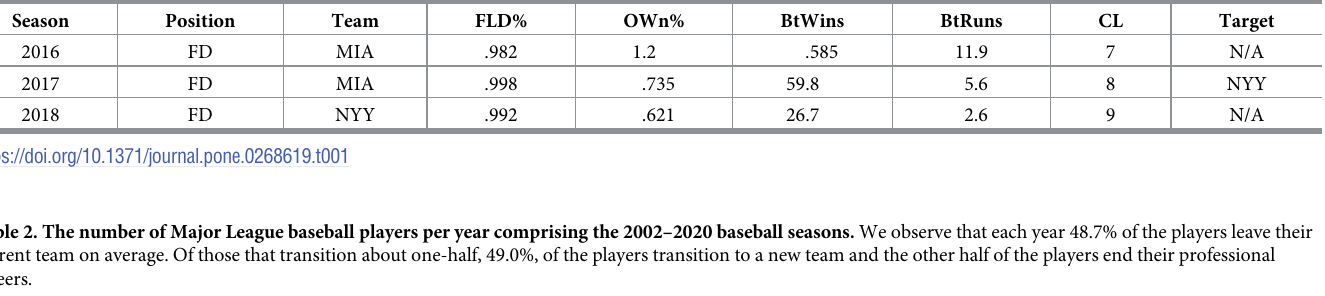
Table 1. Three years of collected and feature engineered data for a random baseball player. We observe that at the conclusion of the 2017 season, this player transi- tioned from the Miami Marlins (MIA) to the New York Yankees (NYY). Thus in 2017 his target value is set to NYY. In this table, and in Table 3 we use the abbreviation CL for career length (an engineered variable).